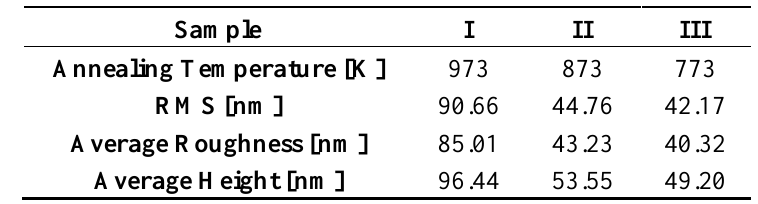
Table 2. Surface morphological analysis of different samples annealed on different temperatures using